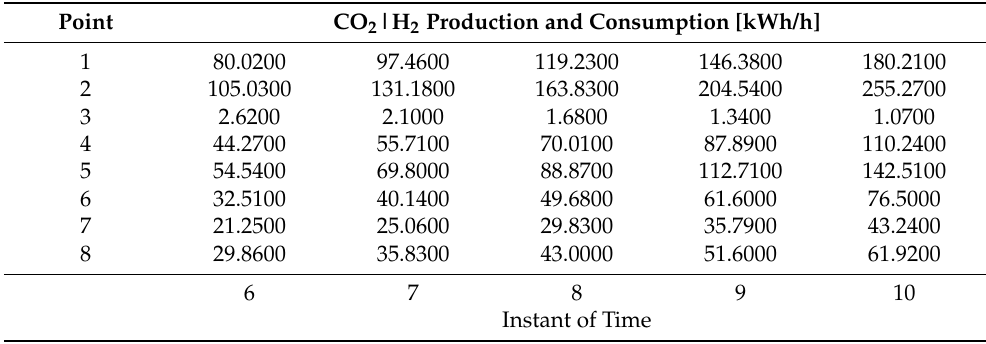
Table 7. CO 2 |H 2 production and consumption values for the pipeline network between the instants of time 6 and 10 with W F = 0.25 and W B =